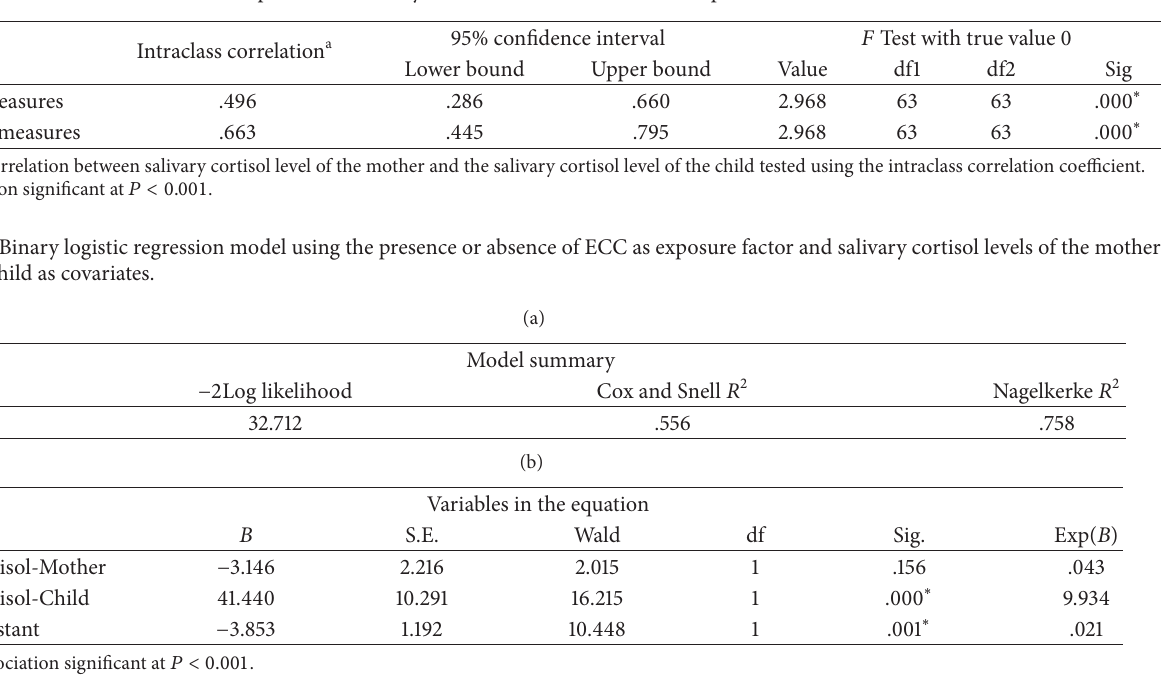
Table 3: Comparison of salivary cortisol levels of children when paired with their mothers.